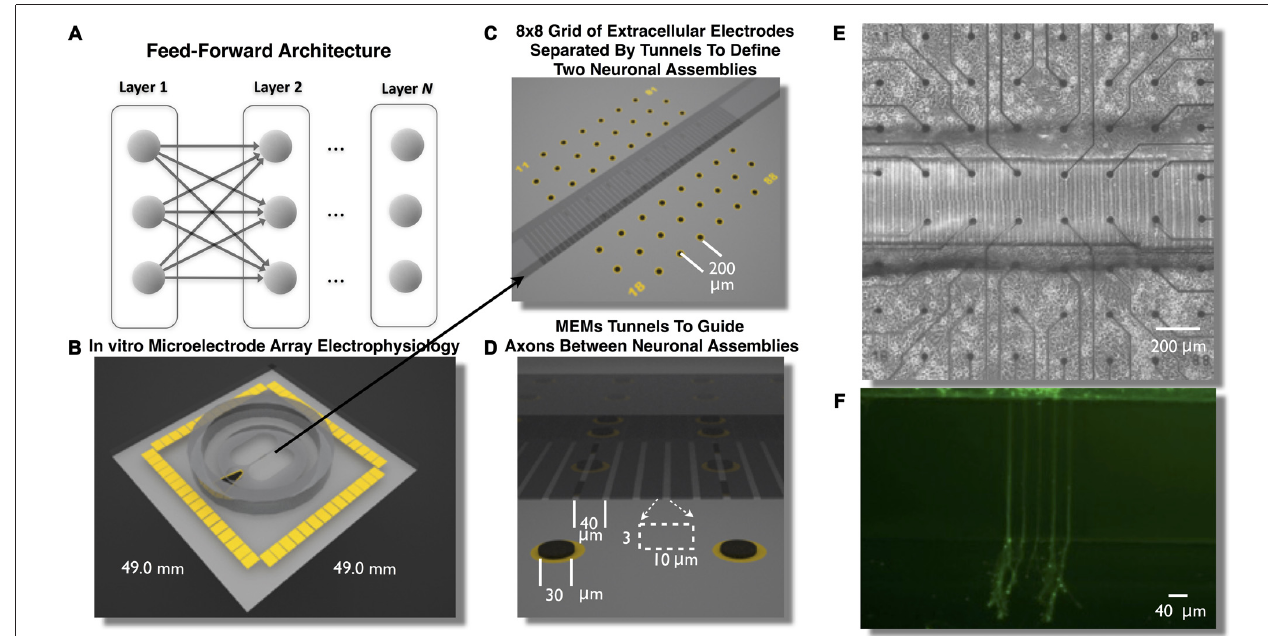
FIGURE 1 | Feed-Forward network architecture and in vitro microelectromechanical systems (MEMS) device for the study of neural transmission in living cortical networks . While there are many unique network topologies within the brain the feed-forward network, illustrated in (A) , is commonly used as a generic model to study the properties of neural transmission of information. We created a living analog of a two-layer feed-forward network to address this issue using a polydimethylsiloxane (PDMS) MEMs device shown in (B,C) . Each device was located over an array of 60 extracellular microelectrodes (C–E) to measure propagation of neural activity (action potentials) and assess the properties of neural transmission of information between neurons embedded within layers of living cortical neurons in vitro . Each layer of cortical neurons was separated by micro-scale tunnels (C–E) that permitted axonal growth between layers but prohibited soma from entering the tunnels detailed in (D) . Through timed sequential plating neurons in Layer I extend neurites into Layer II (shown in F , calcien image after 3 days in vitro) we achieved directional feed-forward connectivity in a two layer feed-forward network. We then study the transmission fidelity of information encoded in spike trains during the propagation of network activity across each